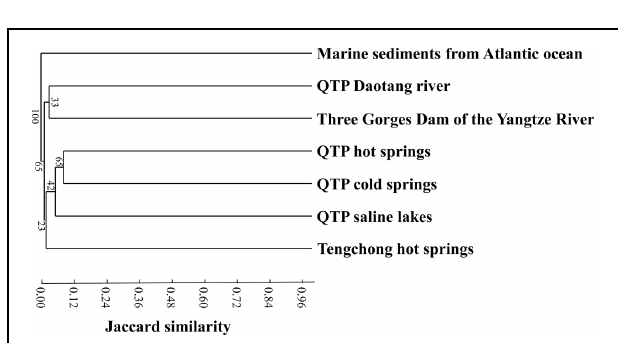
FIGURE 4 | Jaccard similarity-based cluster analysis showing the differences between actinobacterial 16S rRNA gene clone libraries of the QTP cold springs in this study and those from hot springs on the QTP (Jiang et al., 2012a), (hyper-)saline lakes on the QTP (Jiang et al., 2010a), freshwater sample of Daotang river on the QTP (Jiang et al., 2012b), Tengchong hot springs of Yunnan Province, China (Song et al., 2009), Atlantic ocean deep-sea sediment in the edge of the Saharan debris flow near the Canary Islands (Stach et al., 2003), and waters near the Three Gorges Dam in the middle reach of the Yangtze River (Jiang et al.,